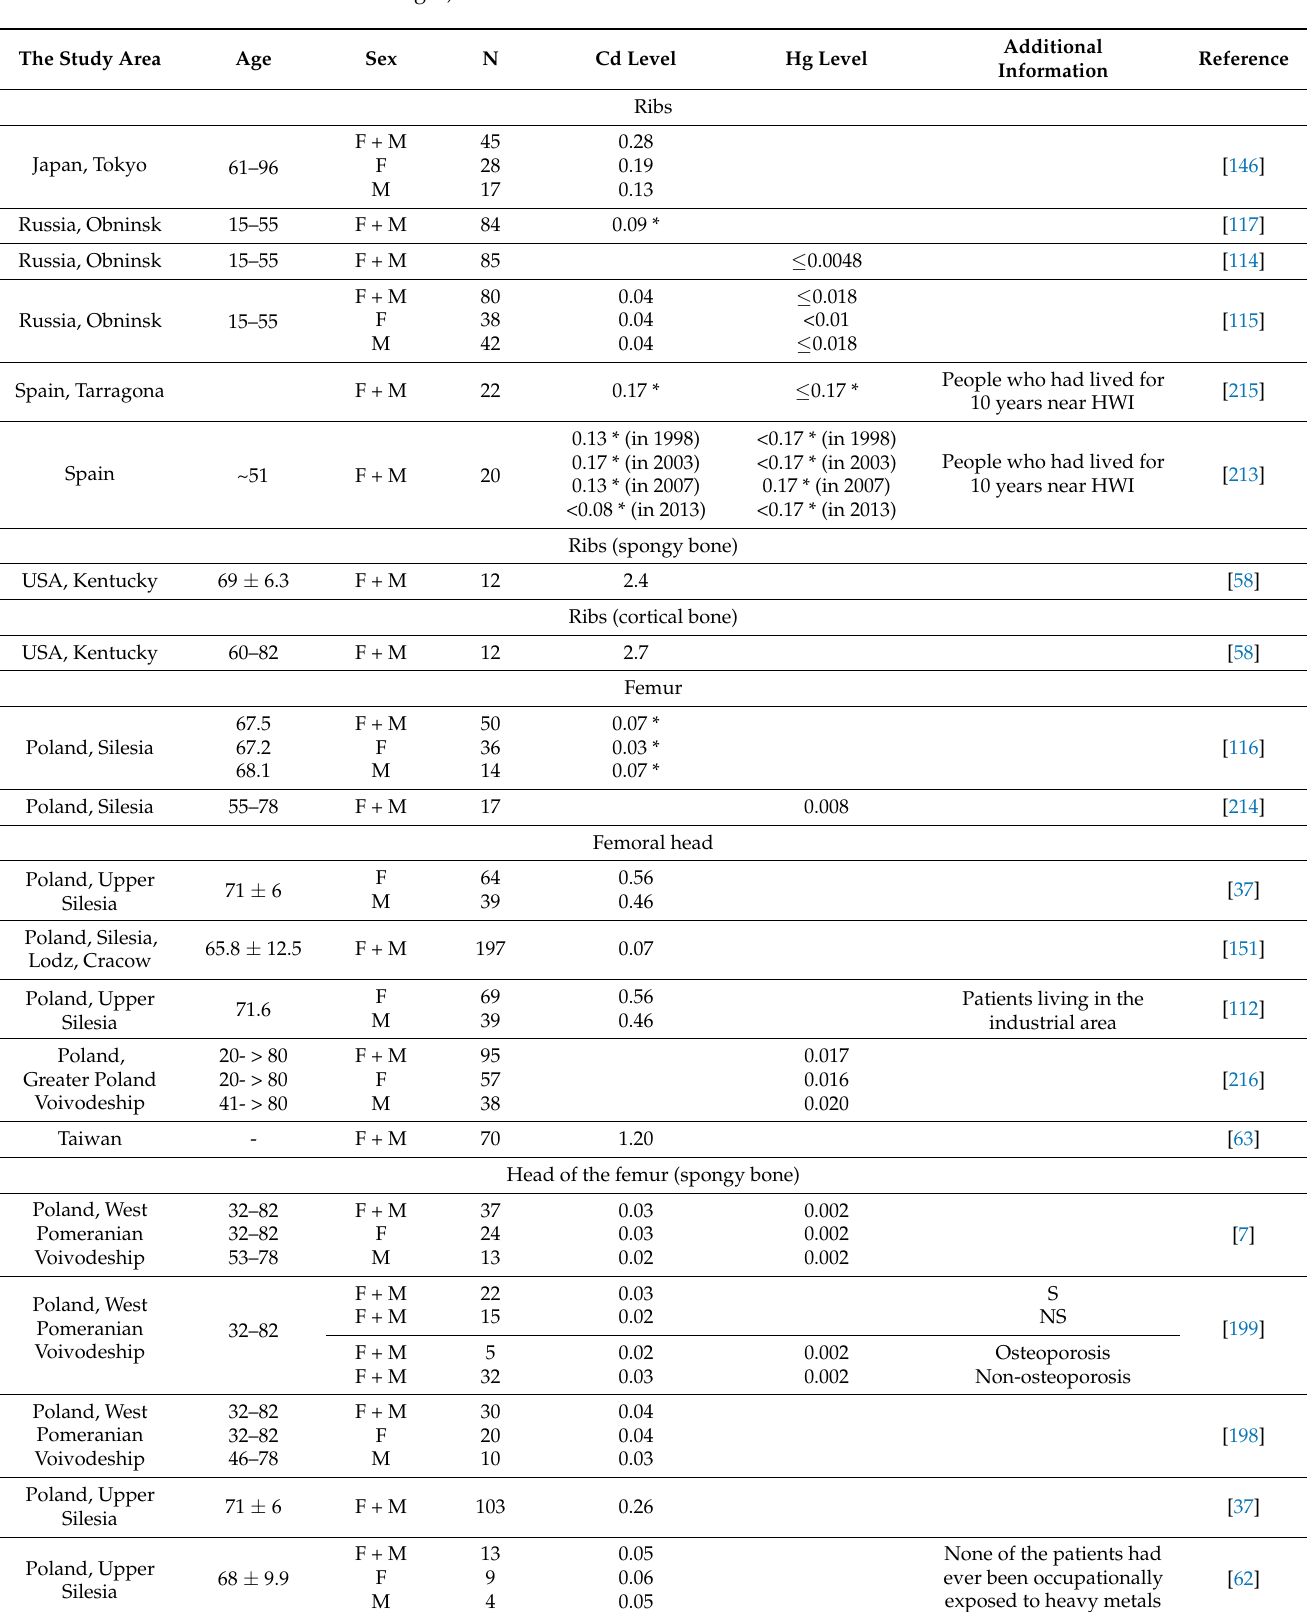
Table 2. Cadmium and mercury levels in human bones in mg/kg dw (F, female; M, male; HWI, hazardous waste incinerator; n, number of participants; NS, non-smokers; S, smokers; * data con- verted from wet weight to dry weight assuming that the average water content of bones is 30% of their